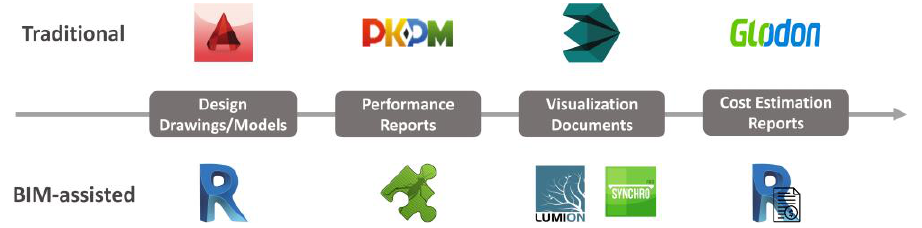
Figure 13. Approach comparison of both